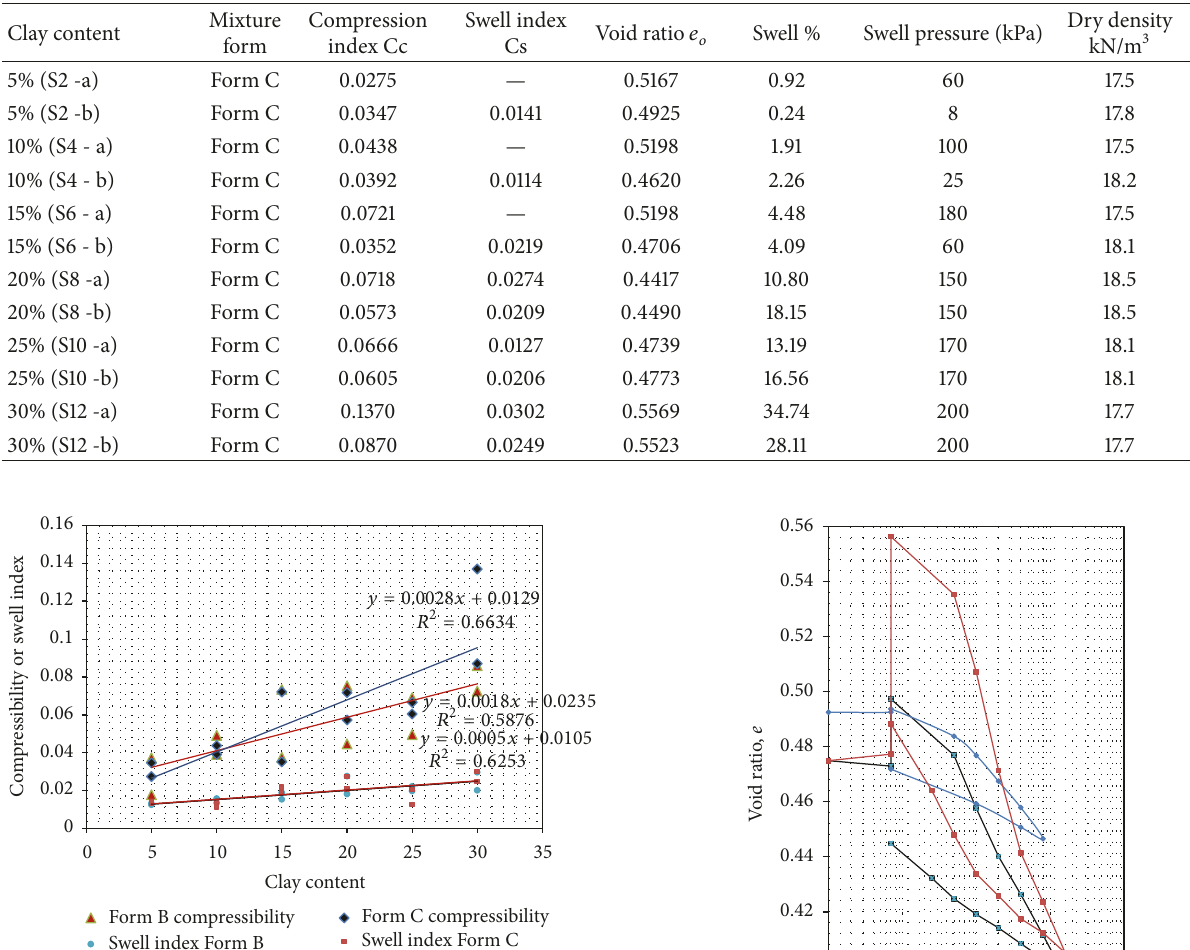
Table 7: Summary of swell and compression data for Form C clay.